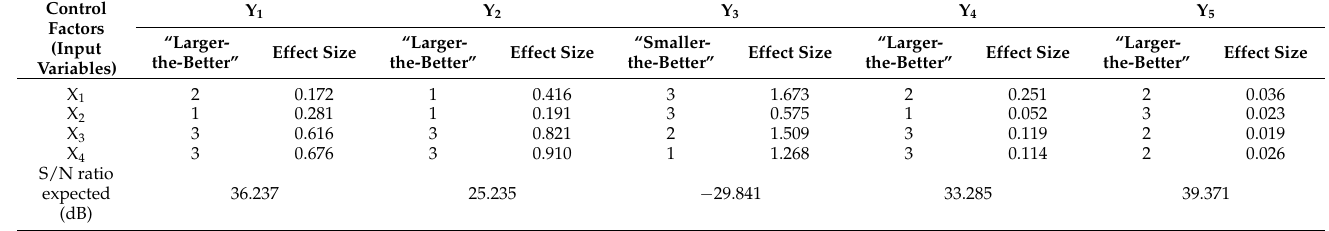
Table 5. Optimal combinations of input variable coded levels, the sizes of their effects on the S/N ratio for the system responses, and the expected S/N values.